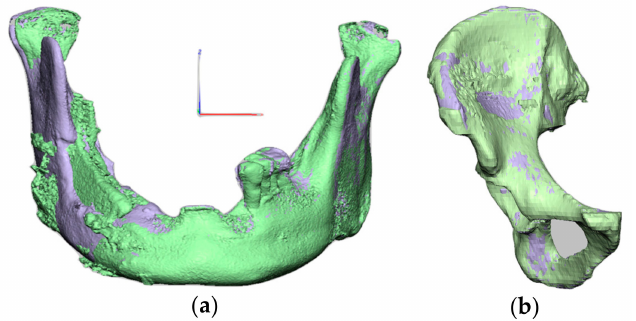
Figure 5. Fused 3D models for comparison. ( a ) Purple is the preoperative 3D model, green is the postoperative 3D model of the mandible; ( b ) Purple is the preoperative 3D model, green is the postoperative 3D model of the iliac bone.